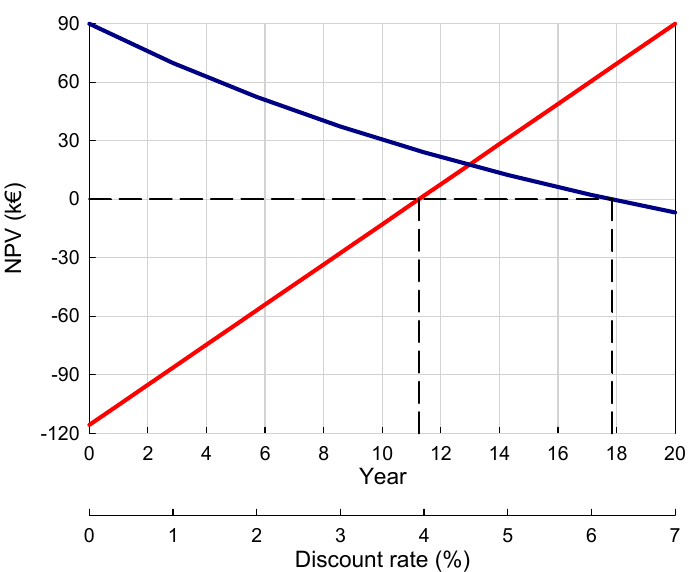
Figure 4. The NPV along the exploitation time (in years) of biogas production facility utilisation (red line) and the NPV function of the discount rate (dark blue line).